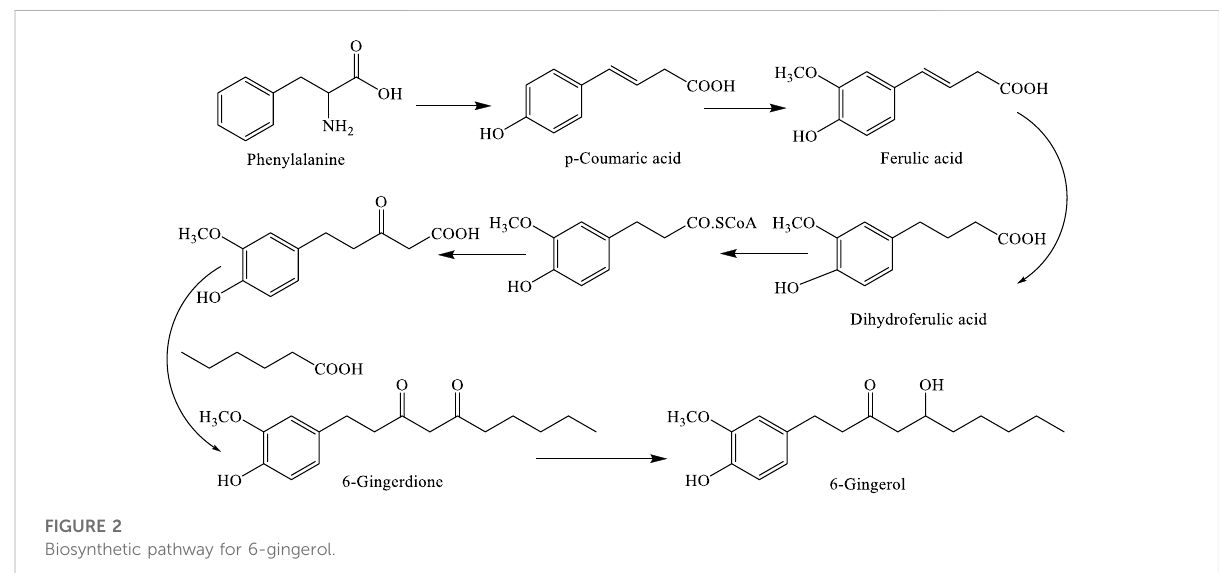
FIGURE 2 Biosynthetic pathway for